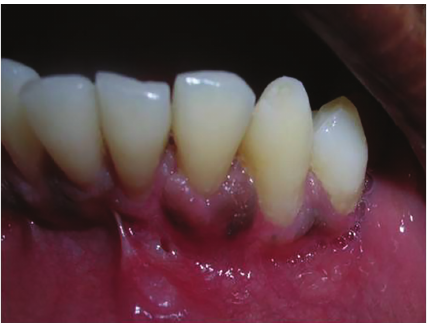
Figure 10: Sixth month postoperative view showing complete recession coverage in relation to tooth number